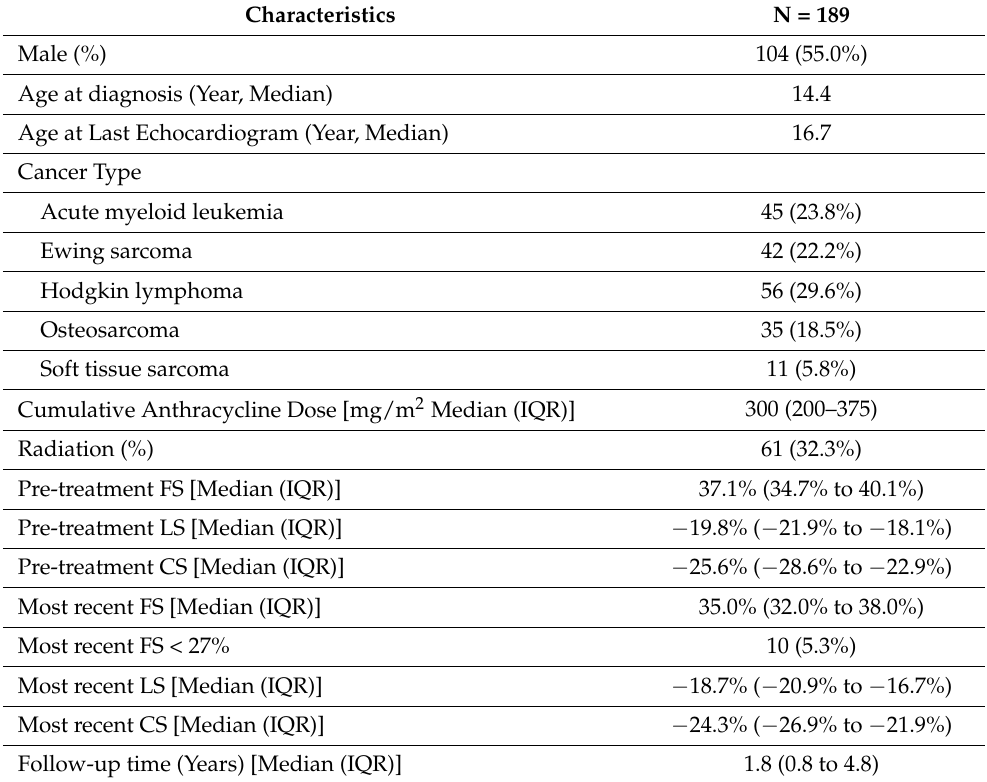
Table 1. Demographic and Treatment Characteristics of